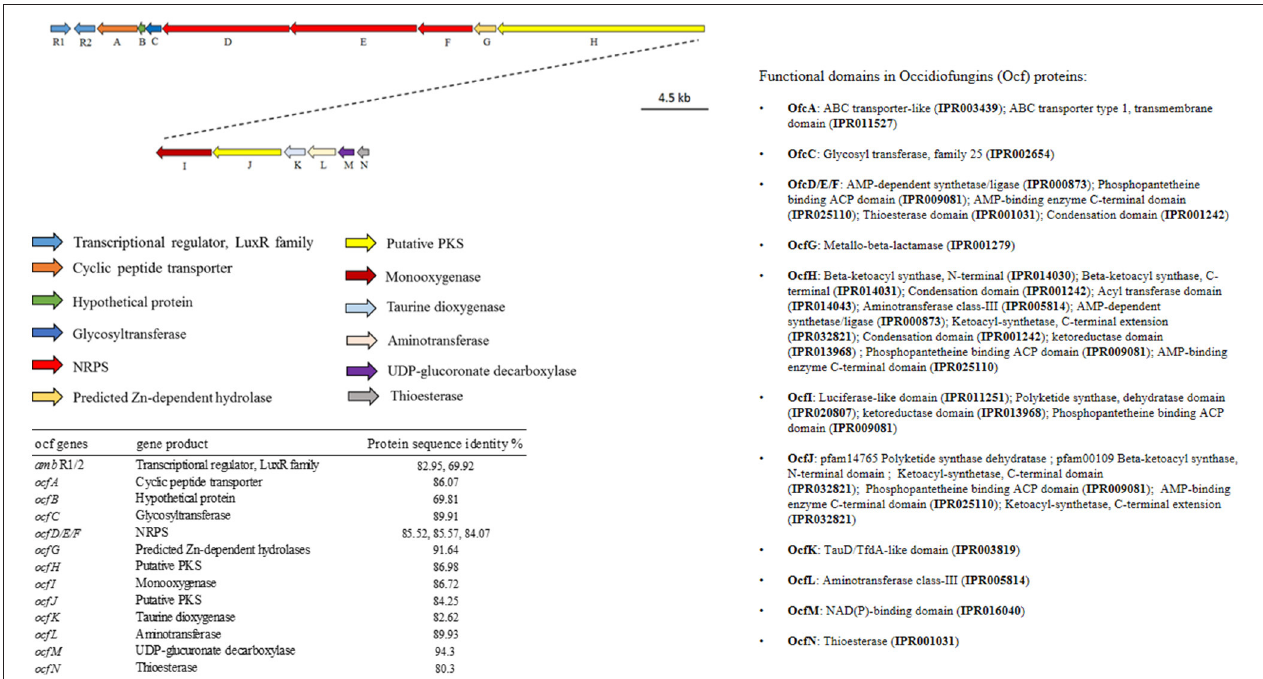
FIGURE 2 | Annotation and graphical representation of the ocf gene cluster in WP42 [Locus tags: EX20DRAFT_04106 ( amb R1)–04091 ( ocf N)] and WP40 [Locus tags: Ga0008008_11691 ( amb R1)–116106 ( ocf N)]. The same colors were used for open reading frames (arrow) encoding for proteins with the same function (arrows). The right pane shows the protein domain.